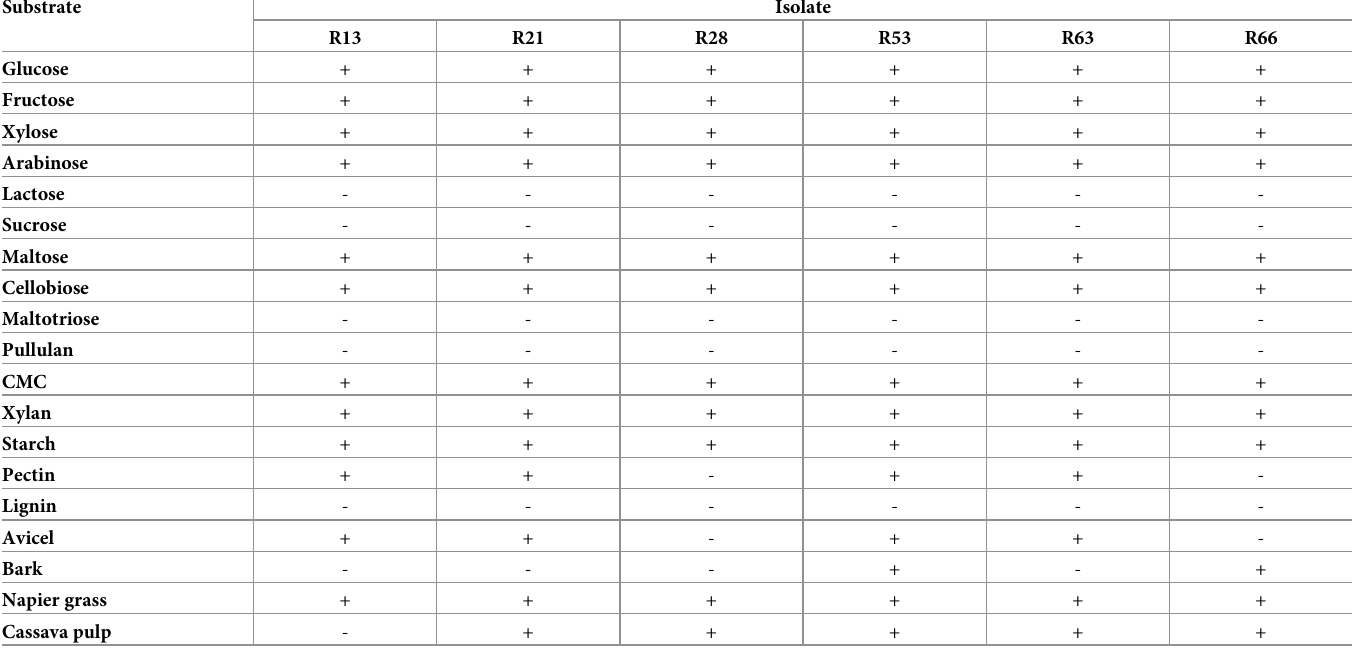
Table 2. Substrate fermentation test of bacterial